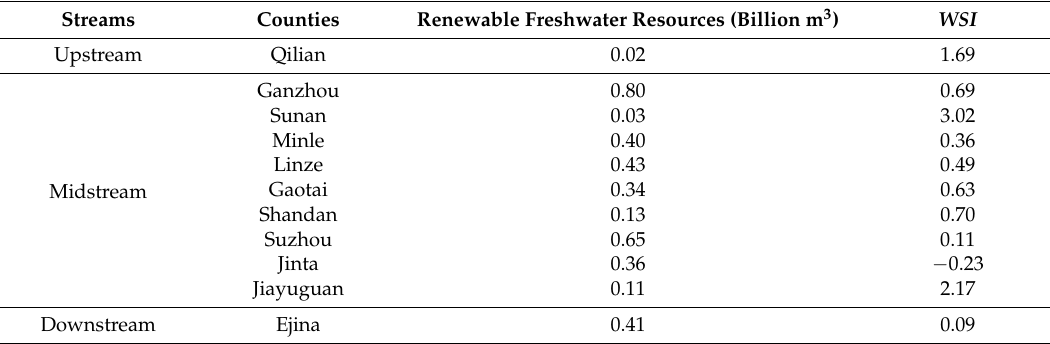
Table 4. Water stress index ( WSI ) at the county level in the Heihe River